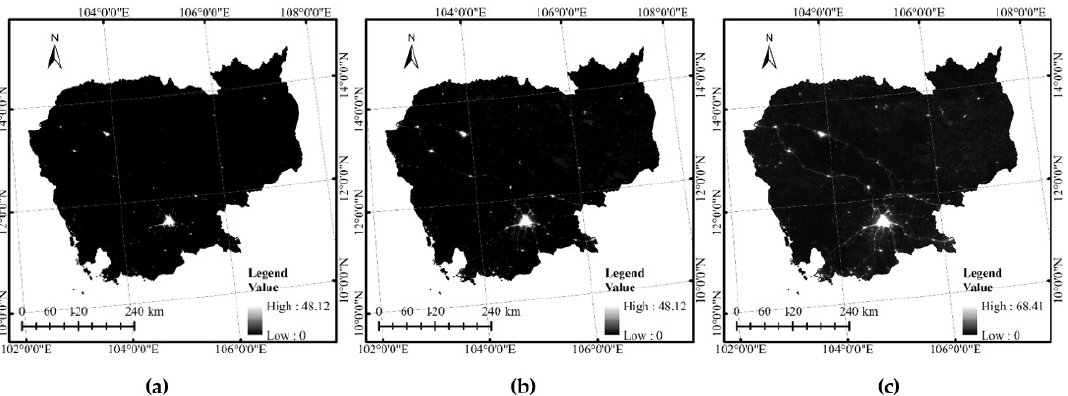
Figure 4. Annual night-light images of Cambodia obtained by cloud-free averaging throughout the years of ( a ) 2012, ( b ) 2015, and ( c ) 2018.